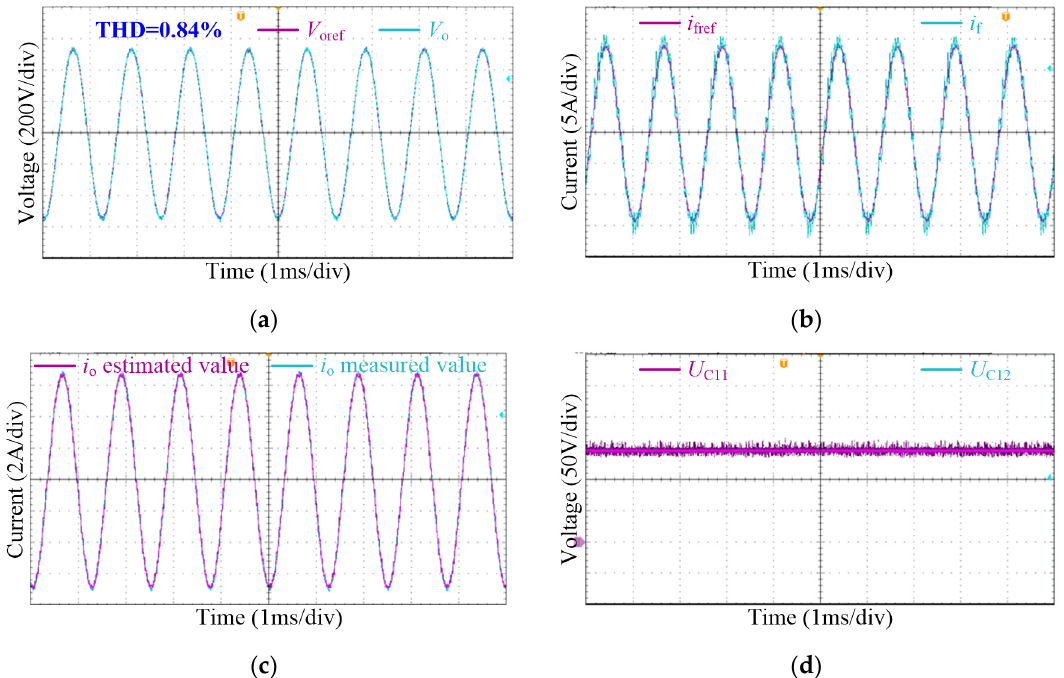
Figure 8. Steady state experimental results: ( a ) Waveforms of V o and V oref . ( b ) Waveforms of i f and i fref . ( c ) Waveforms of the measured value and the estimated value of i o . ( d ) Waveforms of capacitor voltages.